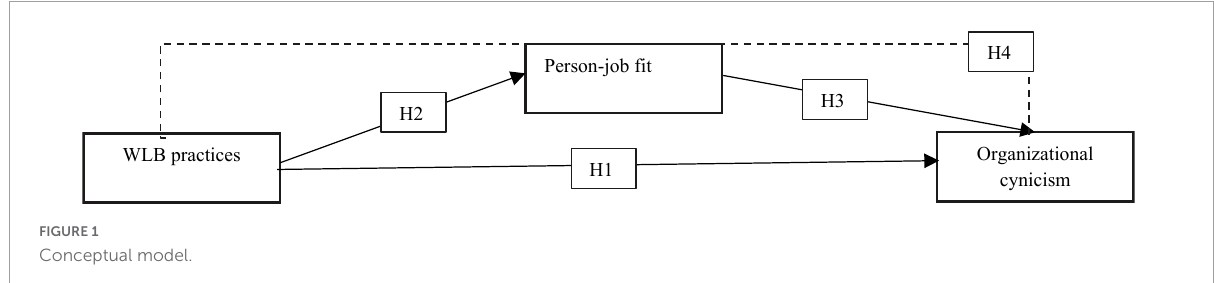
FIGURE1 Conceptual